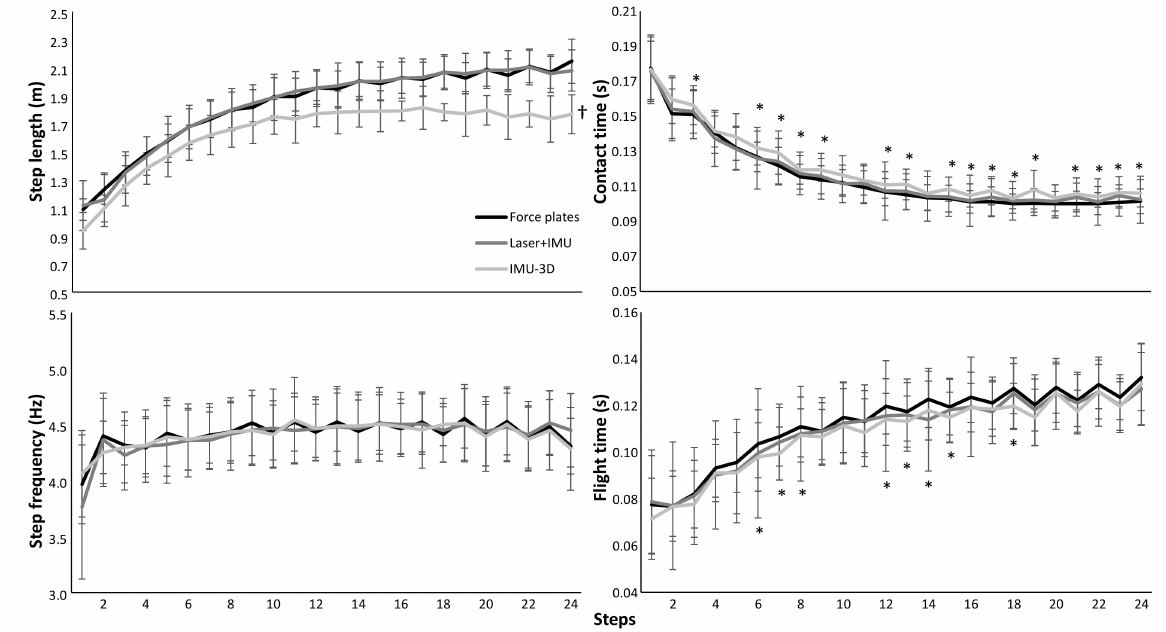
Figure 3. Mean ( ± SD) step-by-step step length, frequency, contact and flight time averaged over all participants during 50 m sprints measured with force plates, laser+IMU and IMU-3D based systems. † indicates a significant difference for each step for this condition with the force plate condition on a p < 0.05 level. * indicates a significant difference between the IMU-3D system with the force plate system for this step on a p < 0.05